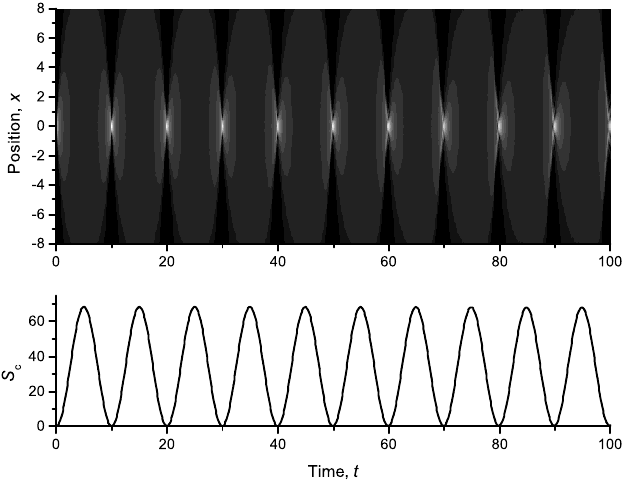
˛ ˛ n ˛ ˛ ˛ of solution (3.1) at τ = 0 . 001 , h = 1 / 128 . ˛ u j obtained using u n j (cid:12) (cid:12) (cid:12) (cid:12)